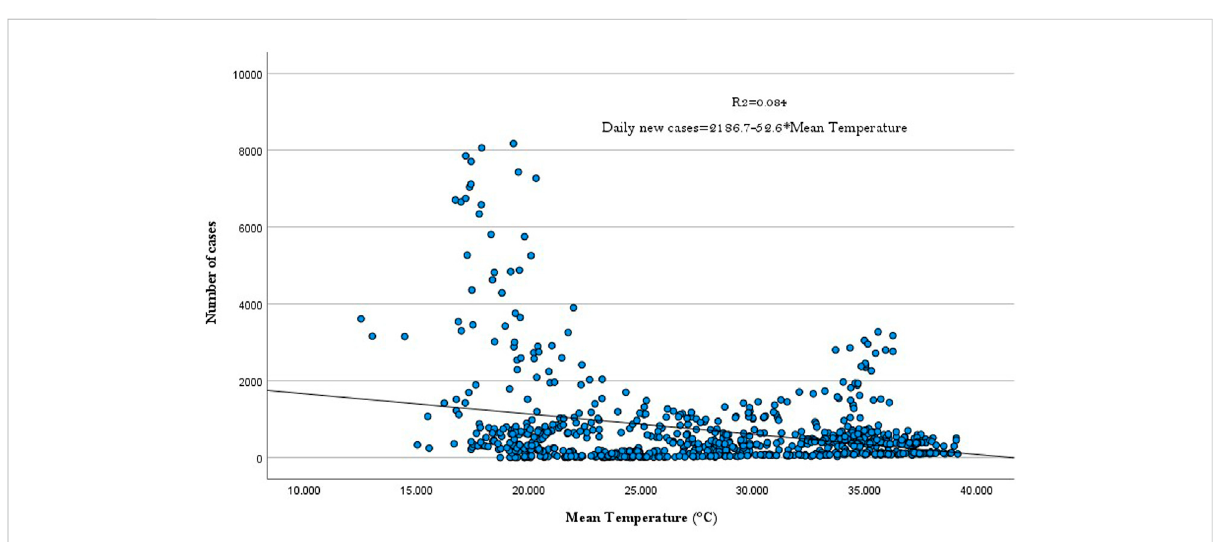
FIGURE 8 ScatterdiagramandsimpleregressionlinepresentingtherelationshipbetweennewdailycasesofSARS-CoV-2andmeanaveragetemperature in Bahrain for 27 months of recorded